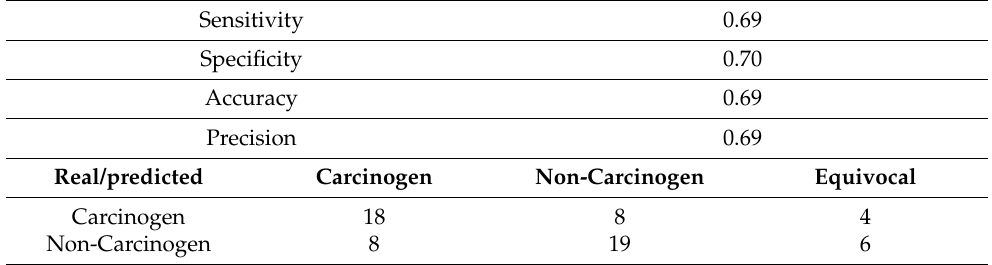
Figure 4. Statistical values of several QSAR models (Toxtree and VEGA for carcinogenicity) compared with VERA results. Table 1. Classification parameters and the confusion matrix of botanicals.